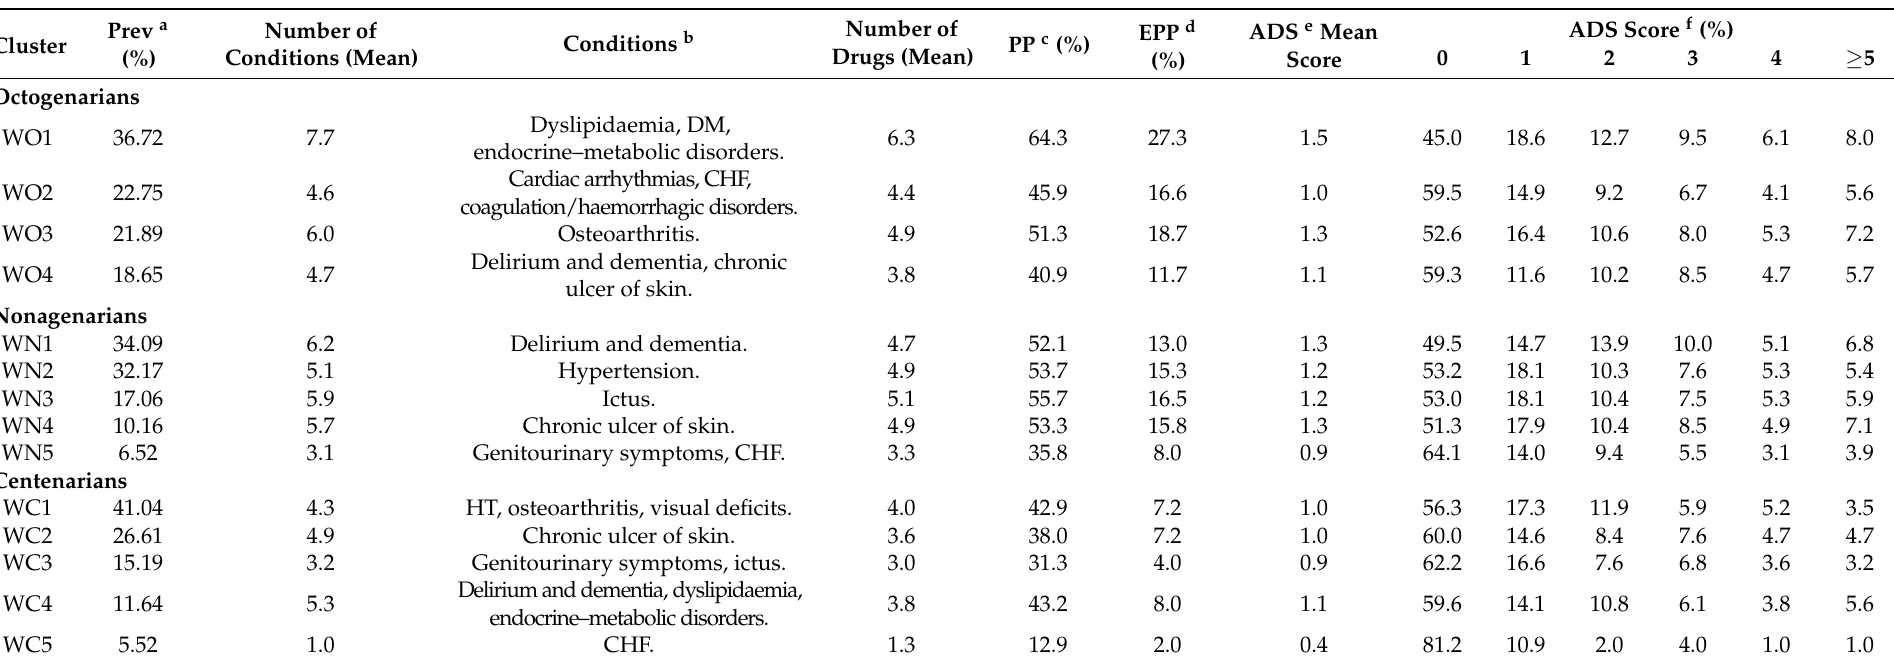
Table 3. Multimorbidity clusters in oldest old women by age group (octogenarians, WO1, WO2, WO3, and WO4; nonagenarians, WN1, WN2, WN3, WN4, and WN5; centenarians, WC1, WC2, WC3, WC4, and